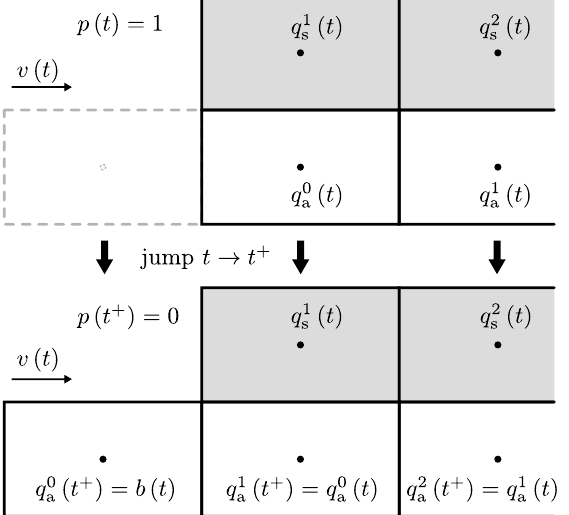
Figure 2. Illustration of a discrete state jump in otherwise continuous state